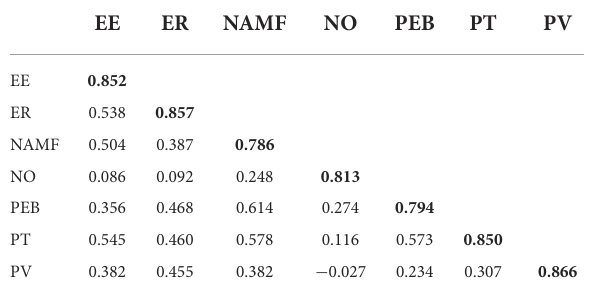
TABLE 2 Reliability and convergent validity. TABLE 3 Fornell and